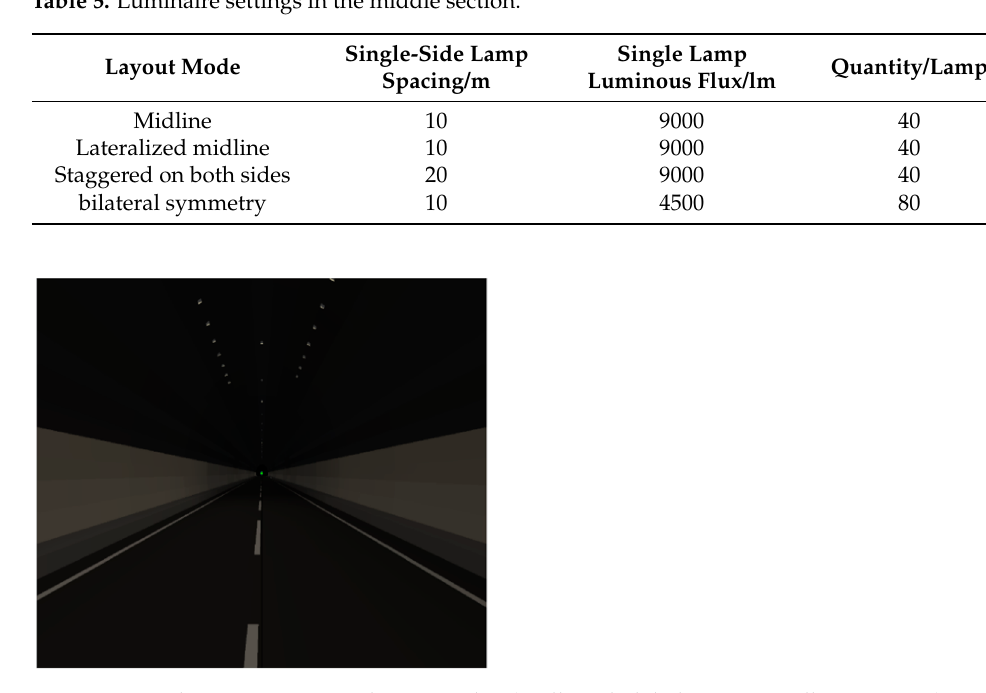
Table 6. Testing personnel